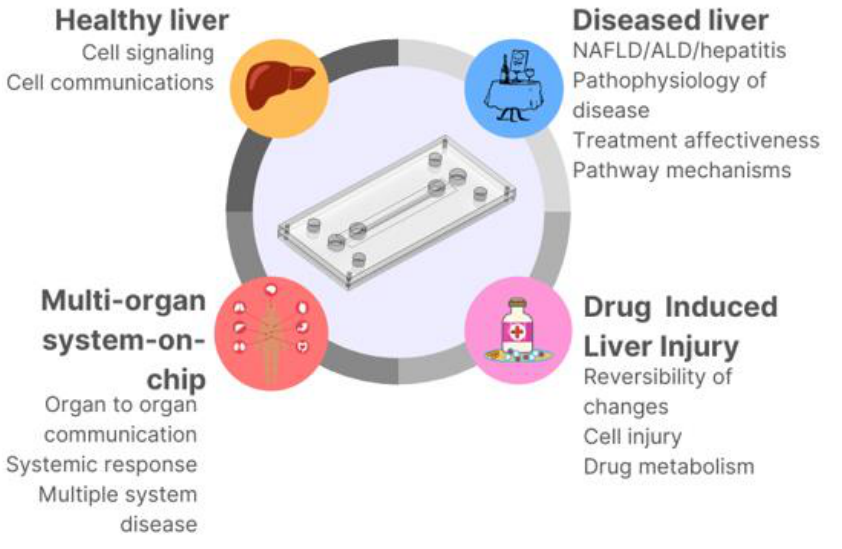
Figure 1. The use of microfluidic devices in different aspects of healthy and liver disease modeling.